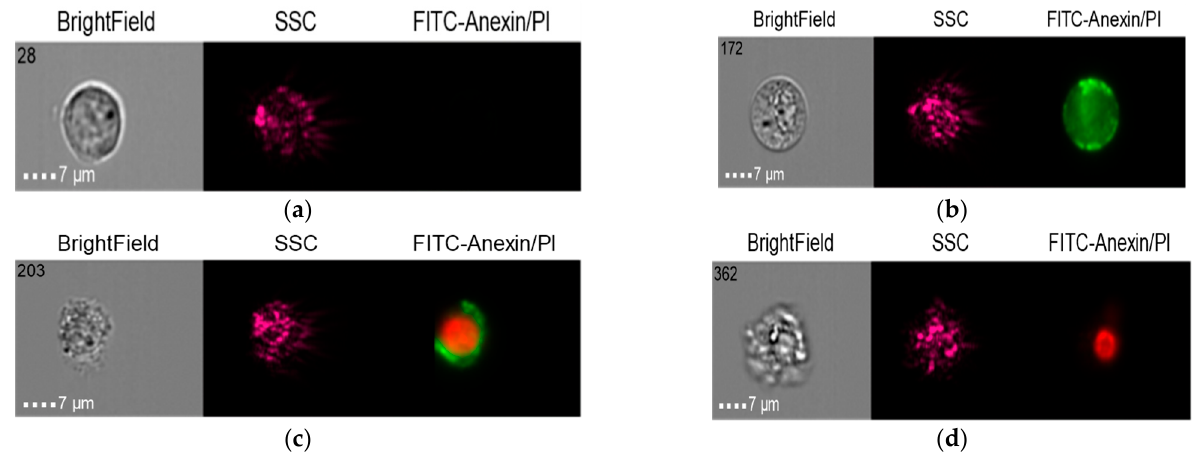
Figure 16. Live cells ( a ), early apoptosis ( b ), late apoptosis ( c ), necrosis ( d ) after co-culture of THP-1 cell line with Nobel Replace NSMP (Nobel Replace NSMP + THP-1+ HDS).